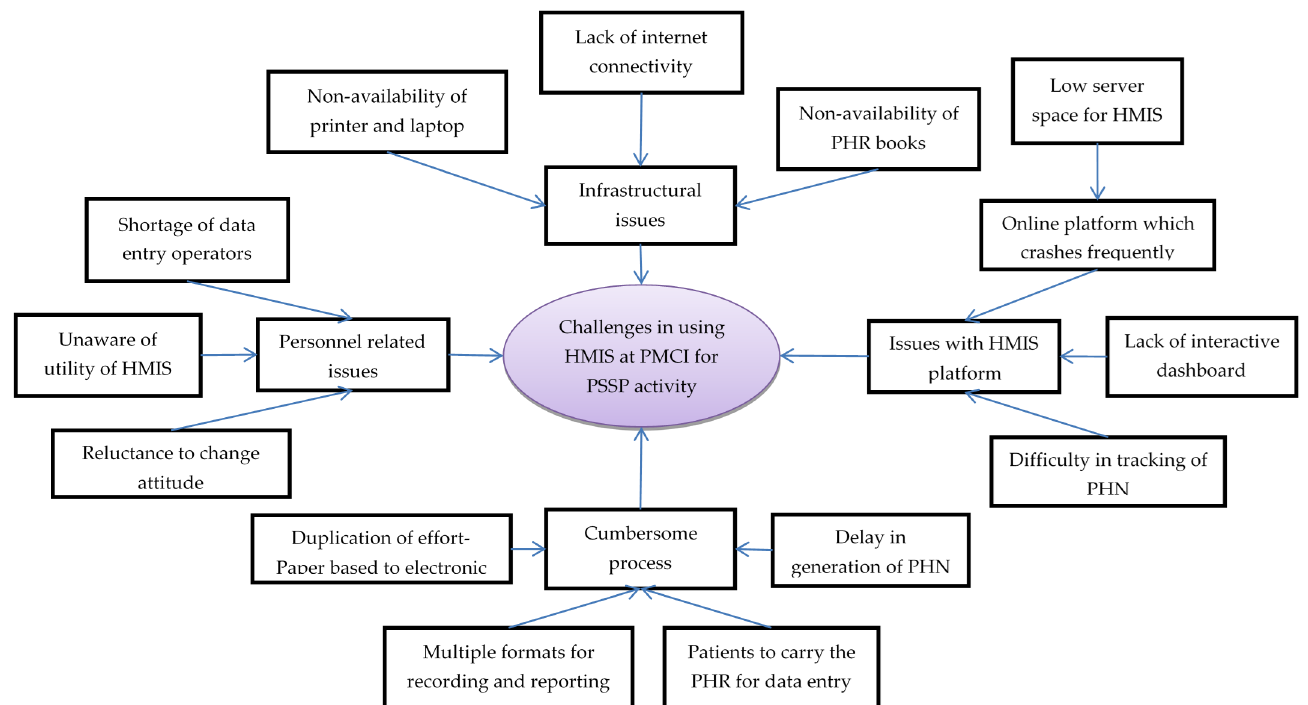
Figure 5. Challenges in using Health Management Information System established in PMCI supported by PSSP in Sri Lanka, 2021. Abbreviation: PMCI: Primary Medical Care Institution; PSSP: Primary Healthcare-System-Strengthening Project (PSSP); PHN: Personal Health Number; PHR: Personal Health Record; HMIS: Health Management Information System.